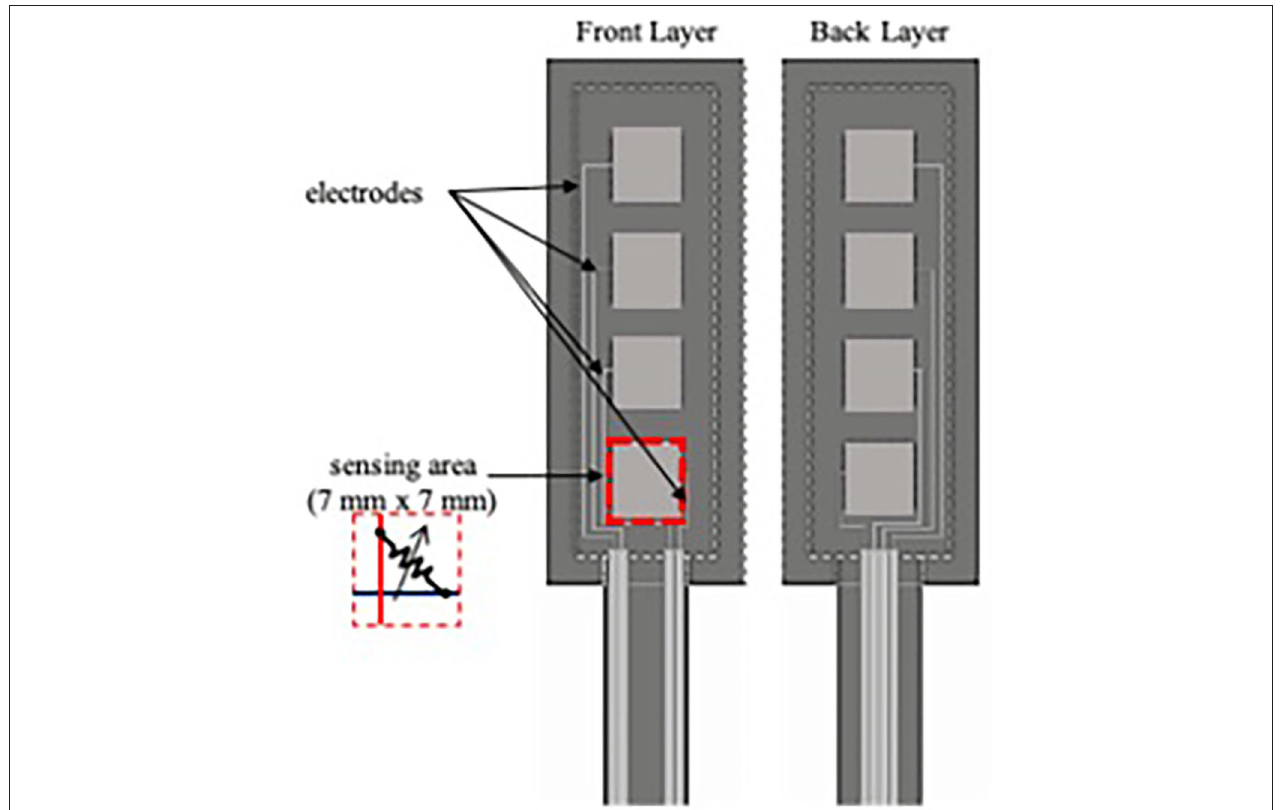
FIGURE 4 | Schematic diagram of flexible force sensor